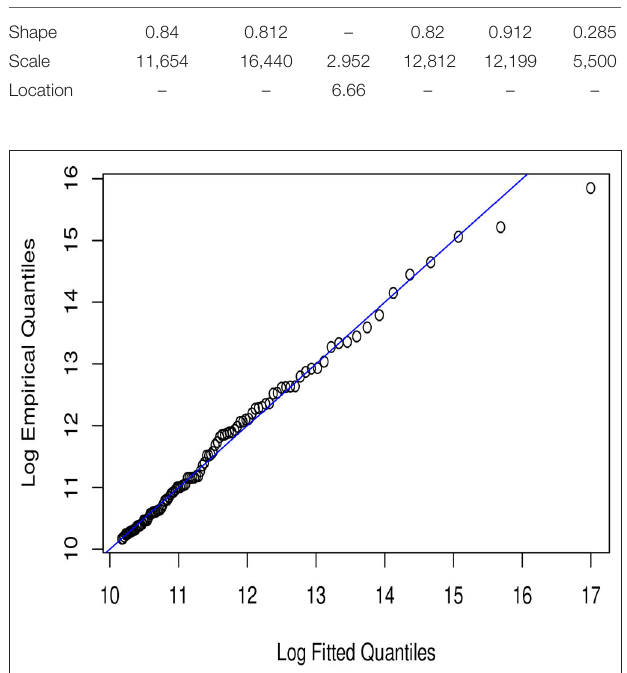
FIGURE 1 | Champernowne